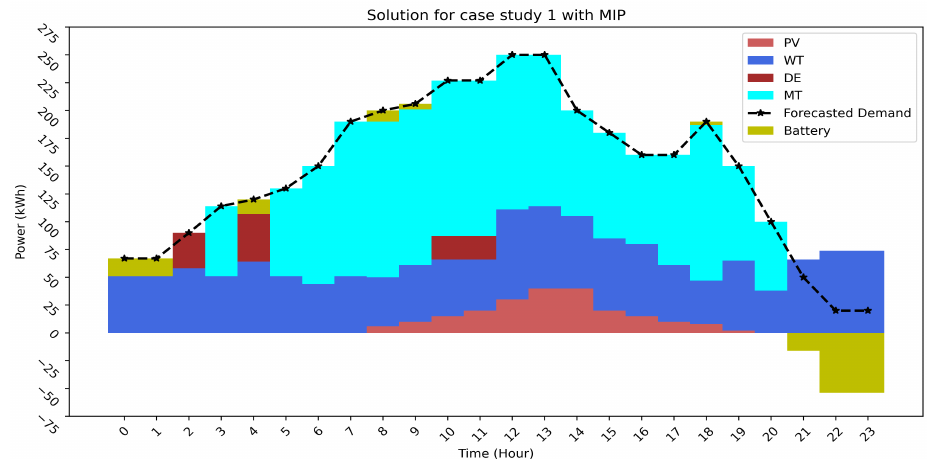
Figure 8. UC uses the BESS-based MIP algorithm